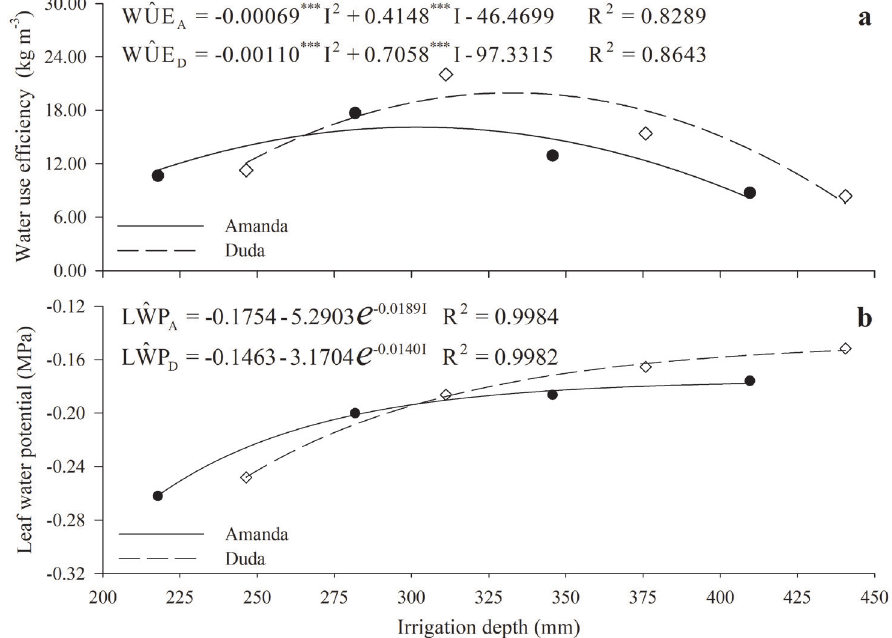
Figure 1 - Efficiency in water use (kg m -3 ) ( a ) and leaf water potential (MPa) ( b ) of Amanda and Duda cultivars depending on irrigation depth. ***Significant at the 1% level of likely by the “t”